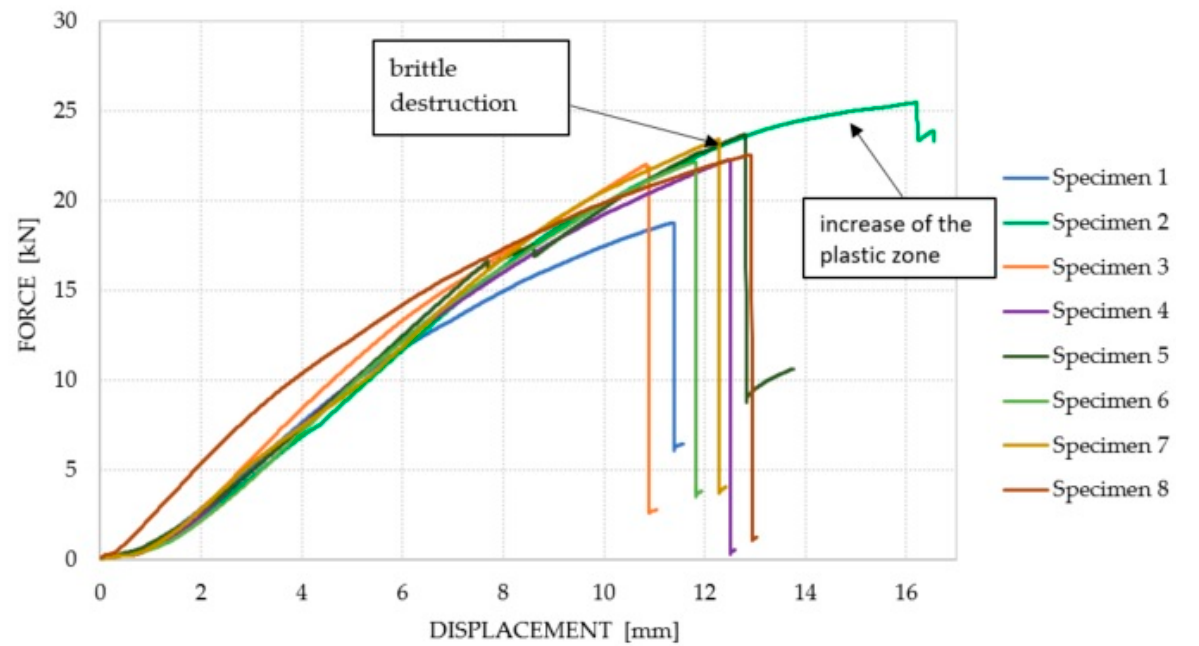
Figure 9. Force–displacement chart for the beams with three layers of reinforcement.